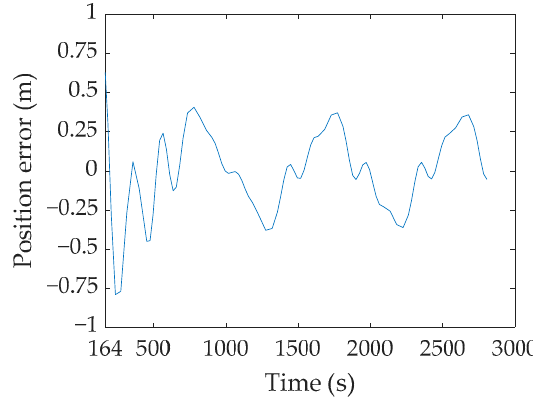
Figure 12. Cross-track position error for the sine curve.